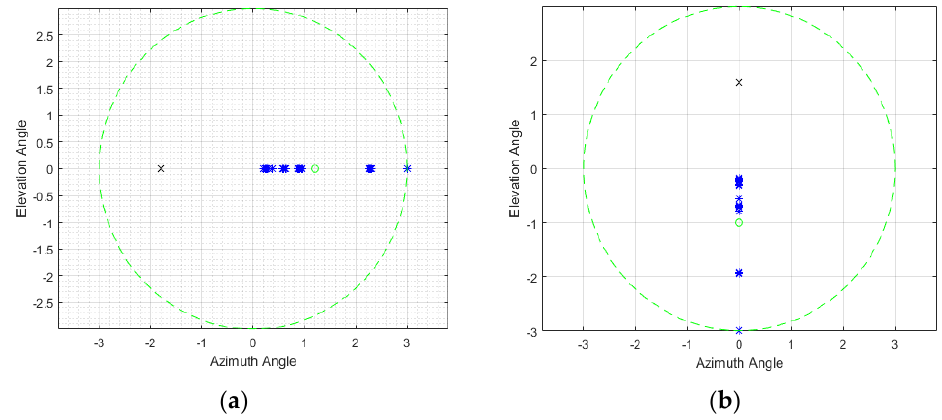
Figure 5. The estimated angle of two unresolved targets by typical phase comparison monopulse radar; ground truth locations of decoy (O) and real target (x), and estimated angle (*). ( a ) same elevation; ( b ) same azimuth.